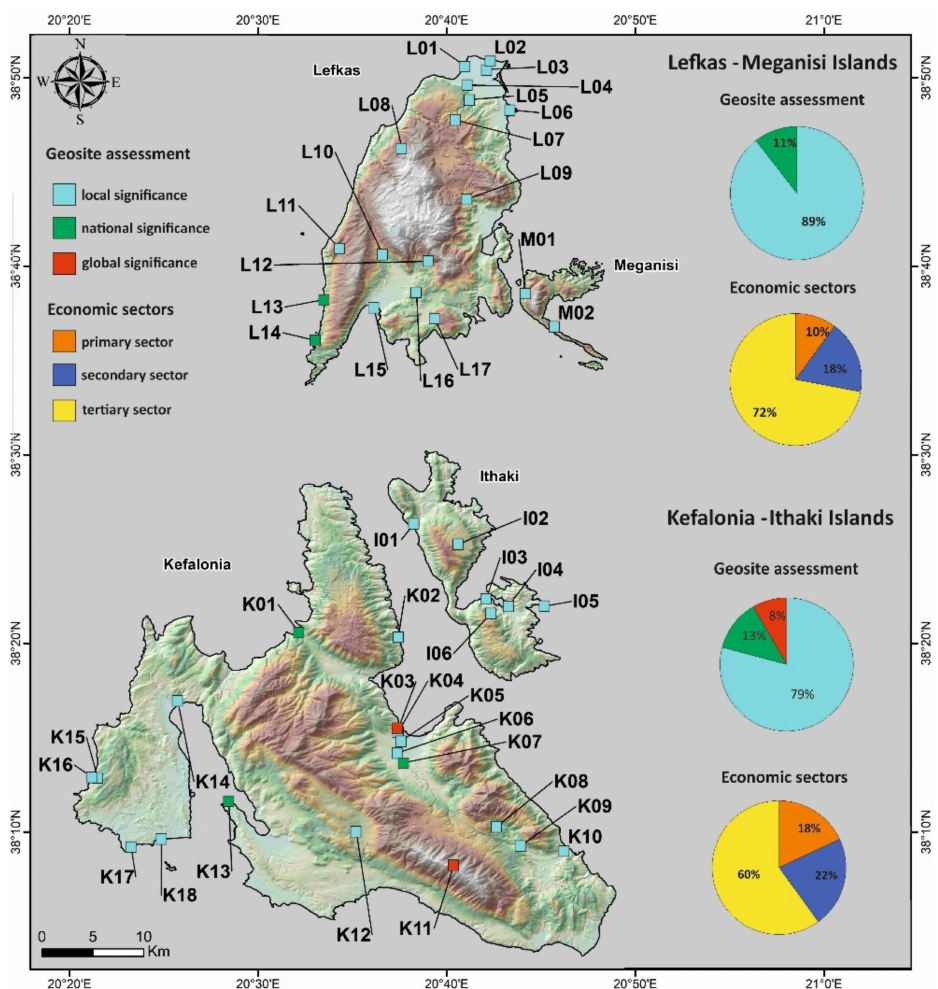
Figure 13. Categorization of the assessed geosites according to the evaluation criteria of Skentos [42], on all four investigated islands. (Data source for the distribution of the economic sectors; Hellenic Statistical